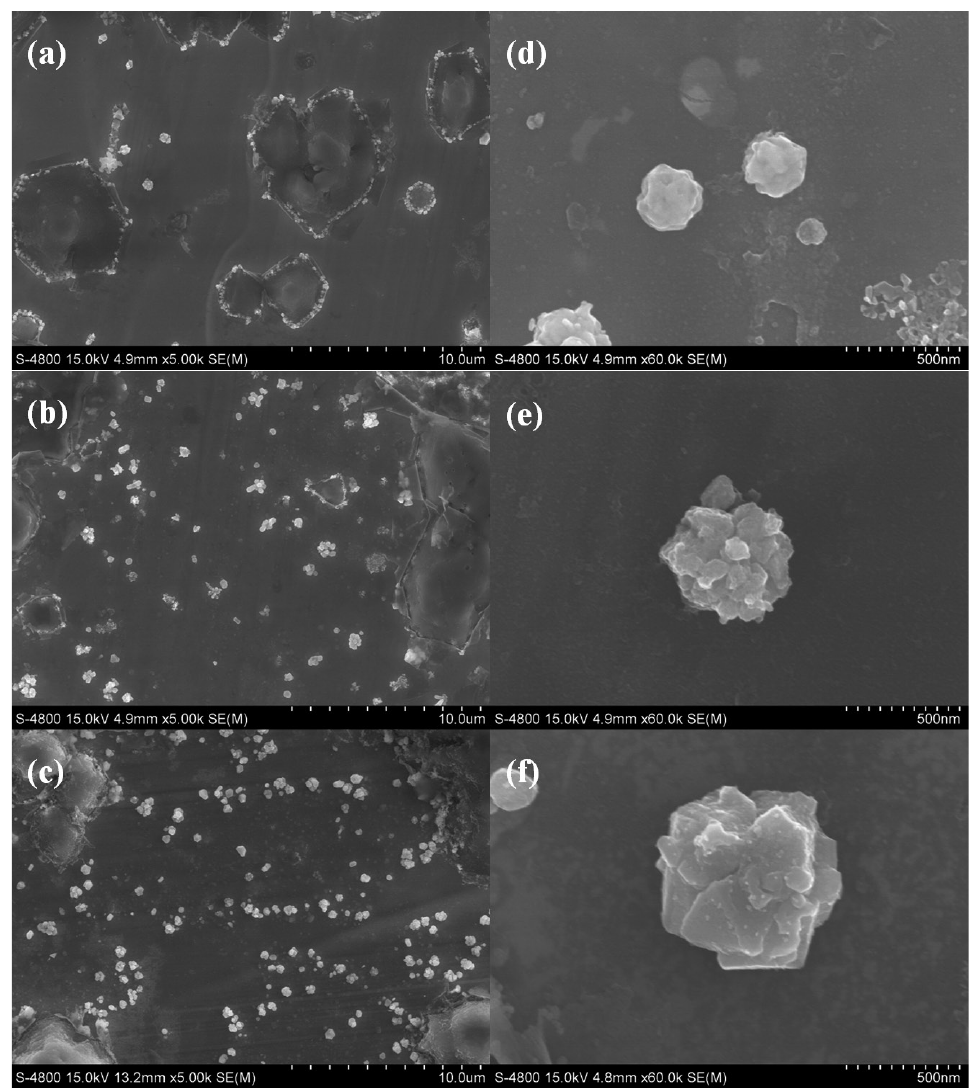
Figure 2. SEM micrographs of Cu O/amorphous compounds by etching Cu-Hf-Al amorphous alloys in different HCl solution for 8 h 2 (a) 0.1 M, (b) 0.2 M, (c) 0.4 M. (d) ~ (f) show magnified images of (a) ~ (c),